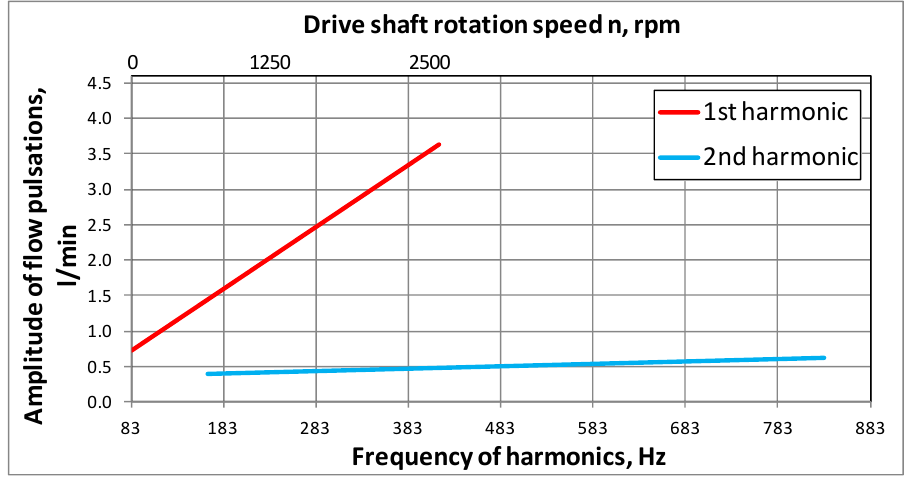
Figure 26. Amplitudes of flow rate pulsations at the pump outlet in an experiment with an “ infi- Figure 27. Amplitudes of flow pulsations in the experiment with a “short” nitely long ” pipeline.